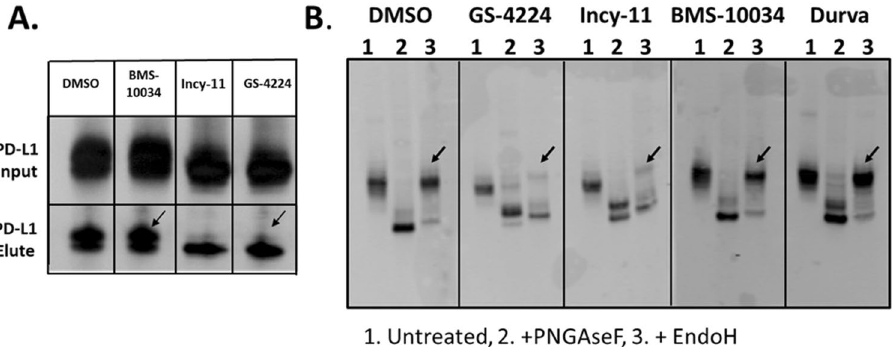
Figure 6. PD-L1 glycosylation differences associated with compound treatments. ( A ) WB signal for FLAG- PD-L1 in HEK293 T cells overexpression system. A high molecular weight glycosylation species is absent from PD-L1 samples treated with dimer-inducing compounds (arrows). ( B ) Dimerized PD-L1 is more susceptible to EndoH than monomeric PD-L1 (arrows indicate the EndoH-resistant